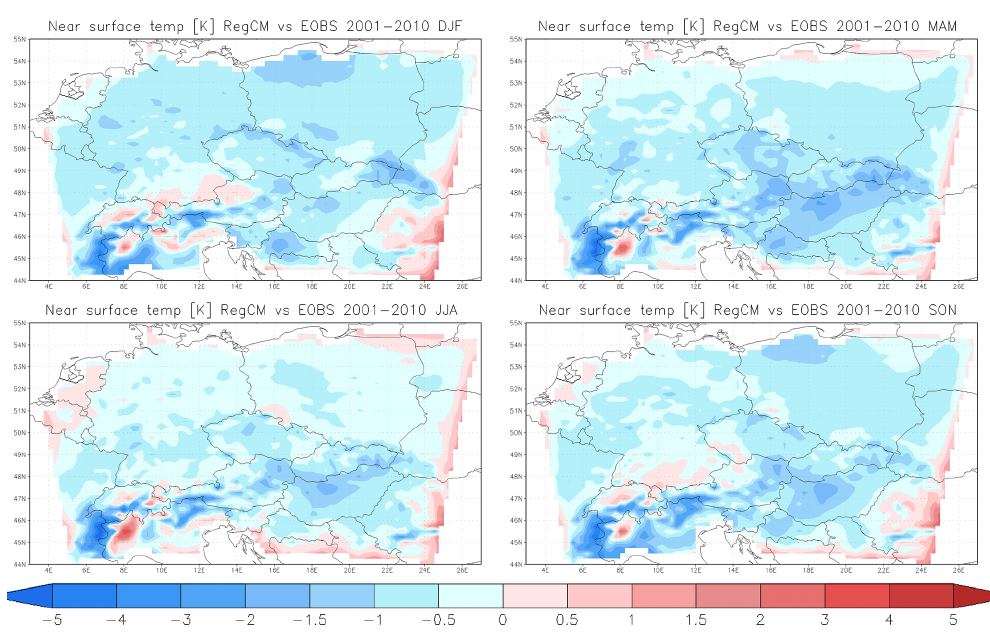
Figure 3. Comparison of the 2001–2010 seasonal mean near surface temperatures from the base (05BASE) experiment with EOBS mea- surements for winter (DJF), spring (MAM), summer (JJA) and autumn (SON) in